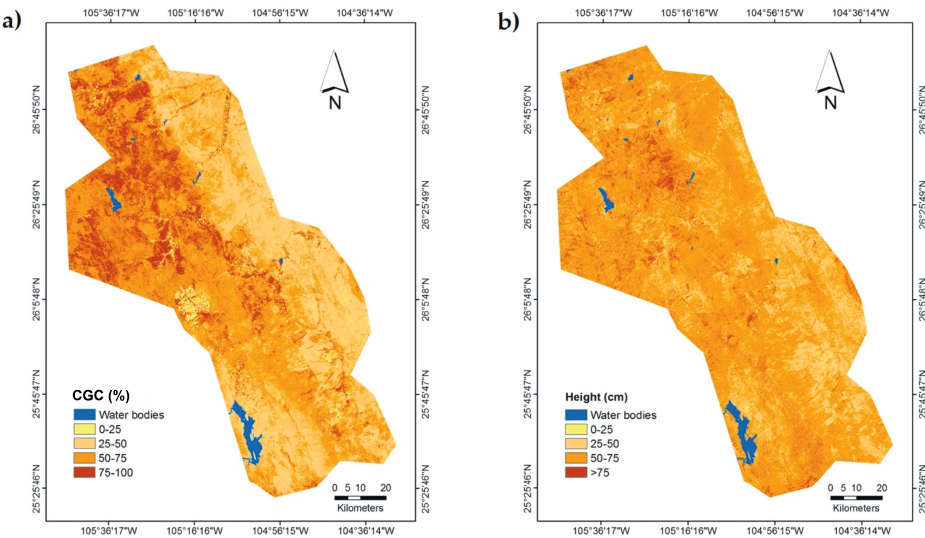
Figure 5. ( a ) Coverage of grass canopy (CGC) and ( b ) grass height distributions for 2010.